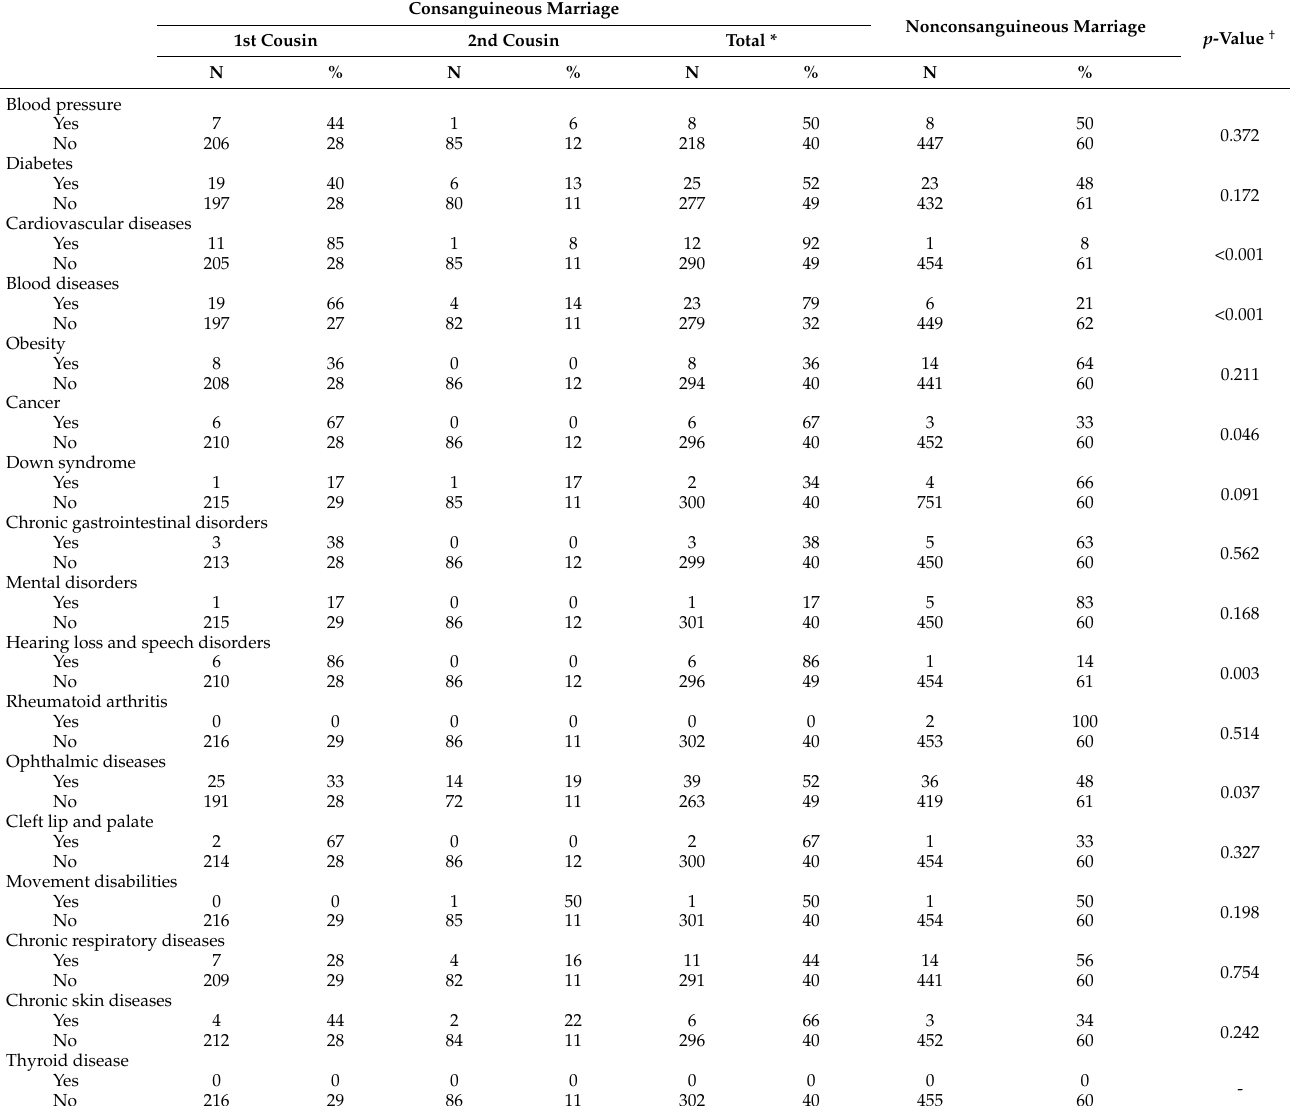
Table 3. Prevalence of health-related issues and hereditary diseases among the participants’ children according to